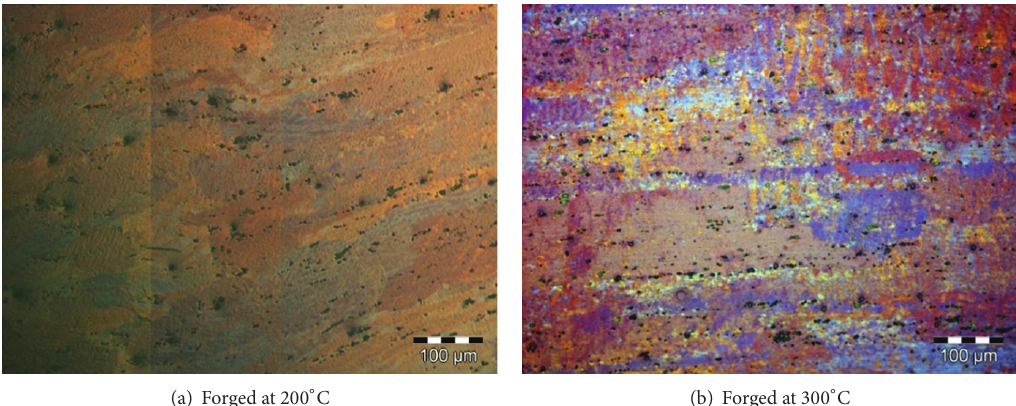
Figure 7: Optical micrograph at 200x of zone 2 of the blade with N2 as starting